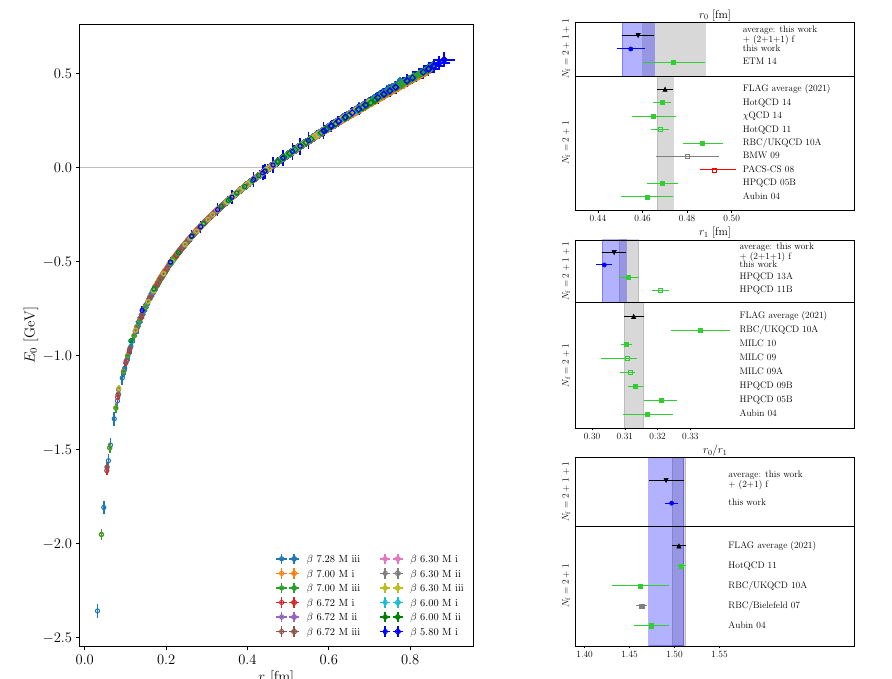
Figure 3. Left: Our results for the static energy in physical units. Right: Comparison plots for r 0 /r 1 , r 0 , and r 1 with the FLAG 2021 averages [17]. The blue bands indicate how the averages would change if our new data is